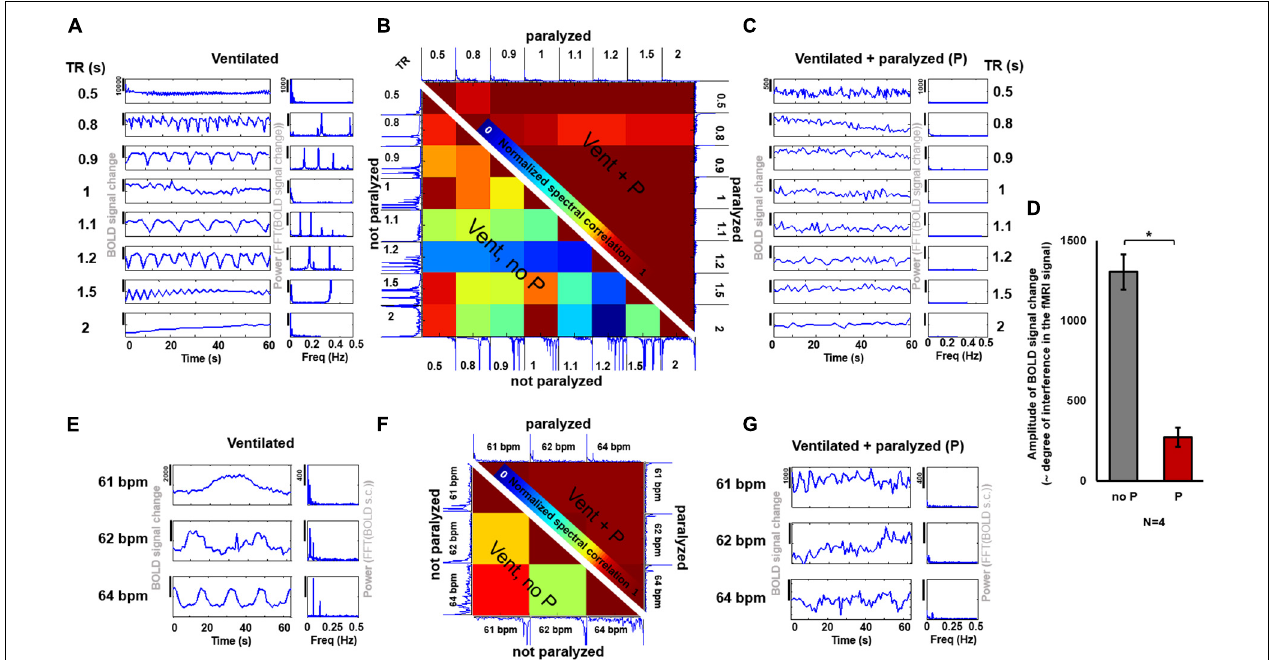
FIGURE 5 | Effect of a muscle relaxant on the emergence of artefactual oscillations. (A , C) The graphs show the time courses and PSDs of the fMRI signal from an animal ventilated at 1 Hz, acquired at 8 different TRs, when the animal is not paralyzed (A) and when it is paralyzed with a muscle relaxant (C) . (B) The matrix shows the correlation values between the spectra from the different time courses acquired at different TRs (under the same ventilatory rate) in a spontaneously breathing animal (i.e., ventilated not paralyzed, as in “ A ”), shown on the lower left half of the matrix, and in a ventilated paralyzed animal (as in “ C ”), shown on the upper right half of the matrix (the matrix is not symmetric, instead it incorporates one half of the “non-paralyzed” matrix and one half of the “paralyzed” matrix, to avoid redundancy). High values indicate a higher correlation between time courses (i.e., low variability, as observed between time courses from paralyzed animals). (D) The bar plot shows the averaged amplitude of the BOLD signal change (indicative of the level of interference) in non-paralyzed ventilated animals and in paralyzed ventilated animals ( N = 26 time courses, acquired at variable TRs, from 4 animals, for each of the two conditions). (P) Pancuronium. (E , G) The graphs show the time courses and PSDs of the fMRI signal from an animal ventilated at 3 different rates, acquired at TR = 1 s, with (G) and without (E) a paralyzer. (F) The matrix shows the correlation between the spectra of the signals acquired at different ventilatory rates (same TR) while the animal had spontaneous breath (i.e., ventilated not paralyzed, as in “ E ”), shown on the lower left half of the matrix, and of signals acquired while the animal was ventilated and paralyzed (as in “ G ”), shown on the upper right half of the matrix (the matrix is not symmetric, instead it incorporates one half of the “non-paralyzed” matrix and one half of the “paralyzed” matrix, to avoid redundancy). High values indicate a higher correlation between time courses (i.e., low variability). ( ∗ ): p -value < 0.005.